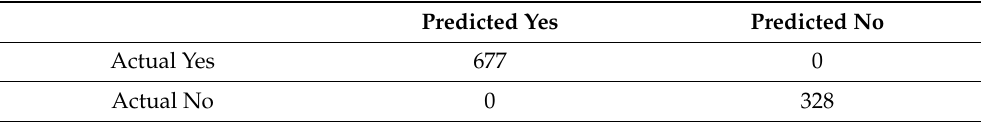
Table 12. Gradient boosted tree confusion matrix.